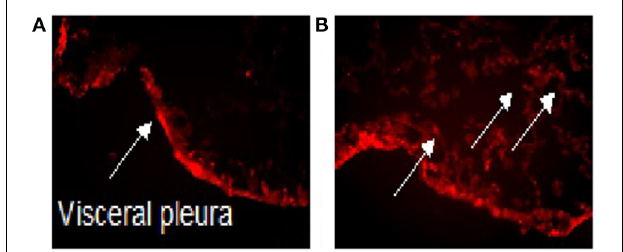
FIGURE 1 | Intra-pleural delivery of PLGA NP. Biodegradable FITC labeled PLGA nanoparticles (which can carry therapeutic compounds conjugated to PLGA) decorated with antibody targeted to mesothelin (a PMC marker) localize to the pleural surface in control mice treated with saline (A) , but diffuse into the lung parenchyma in mice given intra-tracheal bleomycin (B) . The arrow point to FITC labeled PLGA nanoparticles. PLGA, Poly Lactic-co-Glycolic Acid; NP, Nanoparticles; FITC, Fluorescein